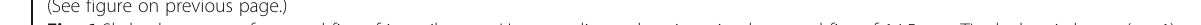
3: Figure S2M) Melanophores are spread over the entire body, including the pectoral fins (Fig. 4h; Additional file 3: Figure S2M). The mouth moves ventrally (Additional file 3: Figure S2M). The proximal region of the pectoral fin is covered by the well-developed operculum (ope) (Fig. 4h, i). Frontal sections of the pectoral fins show that four proximal radials (pr1 – pr4) are each isolated by a zone of matrix decomposition (mdz in Fig. 6g). The first and second proximal radials are single-cell wide (Fig. 6h), whereas the third proximal radial is two cells wide and the fourth proximal radial is two- or three-cell wide along the dorso-ventral axis at the proximal part of the pectoral fin (Fig.